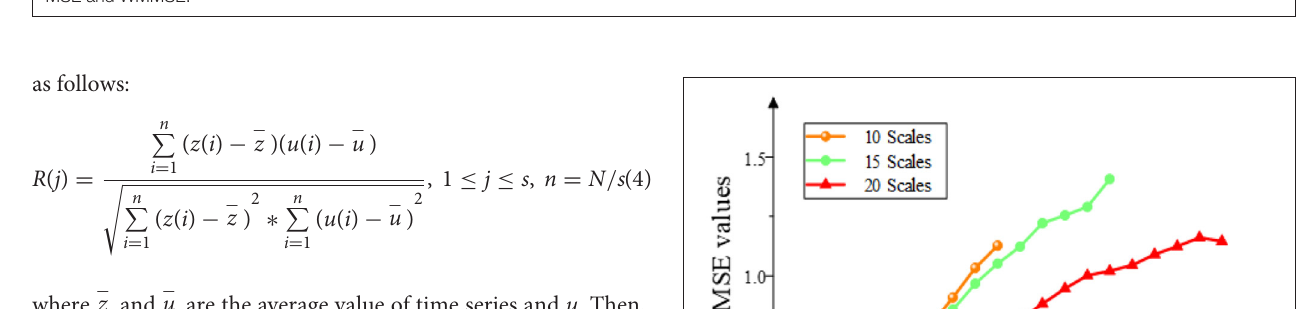
FIGURE 2 | (A) Comparison between MSE and WMMSE. The x-axis represents scales, and the y-axis represents entropy values of traditional MSE and WMMSE. (B) The standard deviation of traditional MSE and WMMSE. The x-axis represents the group, and the y-axis represents the standard deviation of traditional MSE and WMMSE. (C) Comparison of EEG results between WMMSE and traditional MSE. Clinical data from MCI patients are used to compare the two algorithms: traditional MSE and WMMSE.